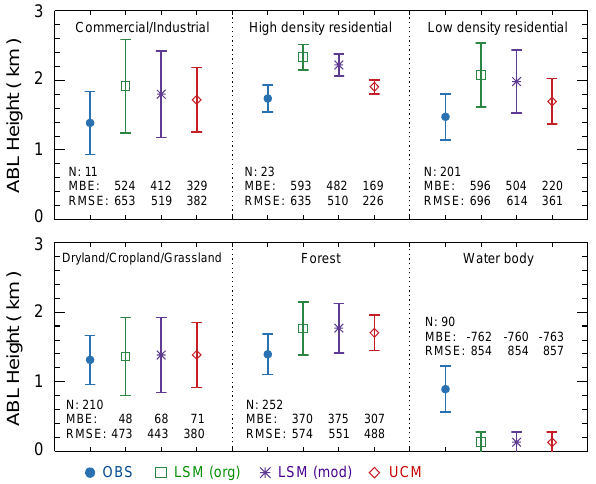
Fig. 14. Statistical model performance for each land-use type from comparison of observed and simulated ABL heights during the three flights in 14–16 August. Vertical bar indicates standard deviation. N denotes the number of data. The MBE and RMSE of each simu- lation are given in the unit of meter.